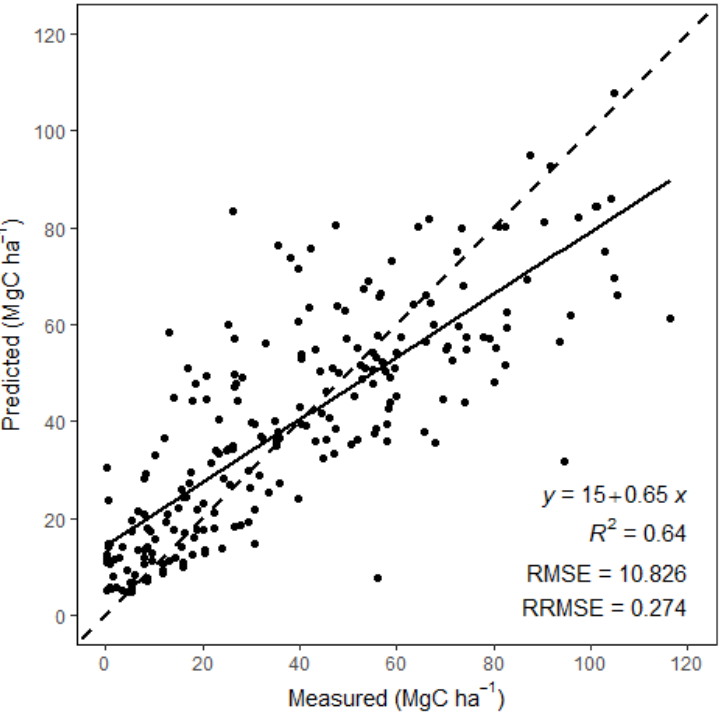
Figure 4. The scatter plot of predicted forest aboveground biomass with that derived from FIA plots. The selected model yields an R 2 of 0.625 with an RMSE of 18.8 Mg/ha (47.6%) based on the “out-of-bag” samples. When using the selected model to produce the biomass map and validated with the biomass from all the FIA plots, the R 2 increased to 0.64 with the regression RMSE = 10.8 Mg/ha (Figure 4), which is smaller than the RMSE based on the “out-of-bag” samples. The R 2 for the whole sample was slightly higher than the out-of-bag sample because each plot would be “seen” by some of the trees in the RF, increasing the R 2 . The out-of-bag samples are not seen by any of the “trees” in the training process; thus, it is a more rigorous validation. Figure 4 shows that the predicted biomass and the FIA biomass distribute well along the 1:1 line. There is a slight overestimation of biomass for plots with low biomass and an underestimation for plots with high